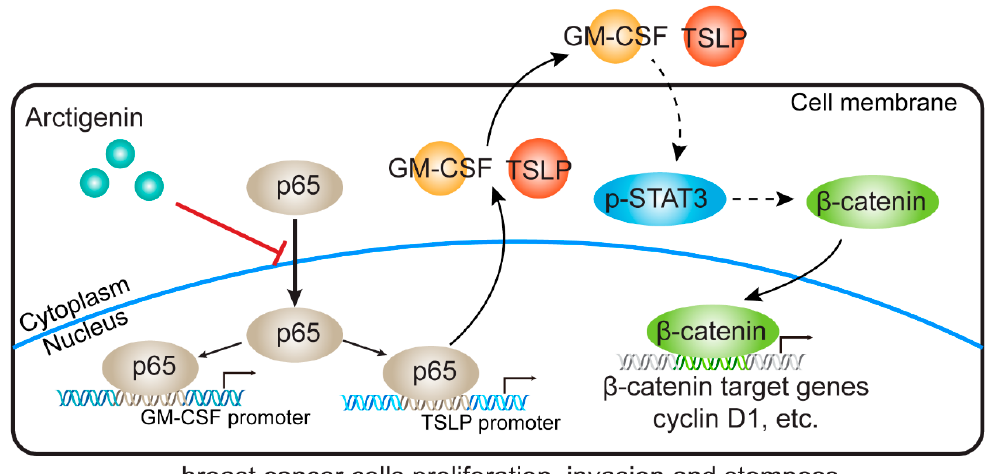
Figure 7. Schematic diagram of working mechanism by which arctigenin suppresses GM-CSF and TSLP in breast cancer. Arctigenin decreased the promoter activities of GM-CSF and TSLP via hindering the nuclear translocation of NF- κ B p65 which is crucial for the transcription of GM-CSF and TSLP. Arctigenin-induced depletion of GM-CSF and TSLP inhibited STAT3 phosphorylation and β -catenin signaling resulting in decreased proliferation, invasion and stemness of breast cancer cells. T-arrows, negative regulation; solid arrows, direct positive regulation; dashed arrows, indirect positive regulation.